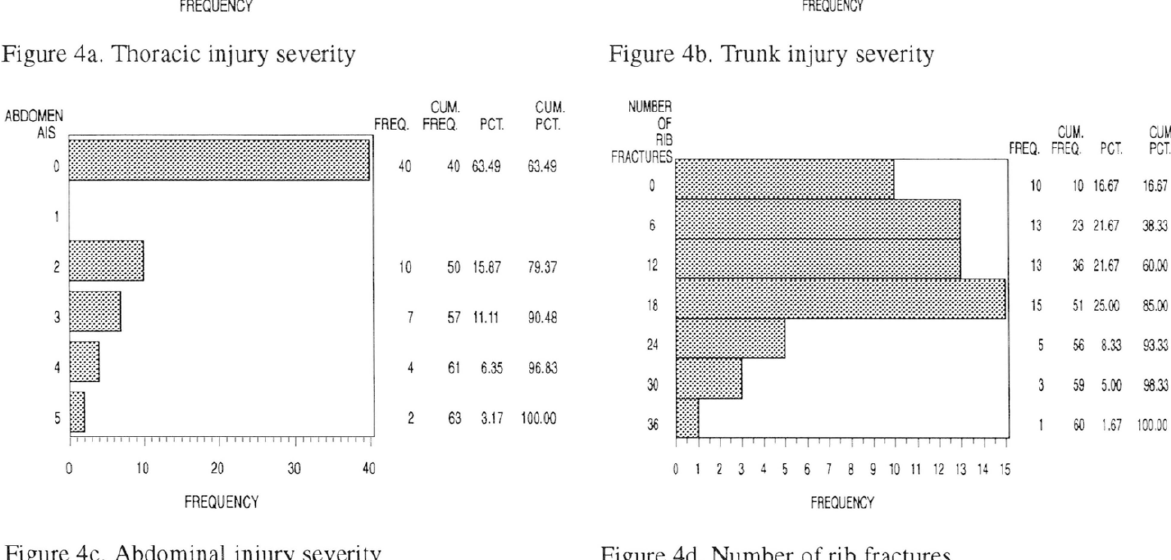
Figure 4c. Abdominal injury severity Figure 4d. Number of rib fractures FIGURE 4 Frequency of the injury severity of (a) thoracic, (c) abdominal, (b) trunk injuries, and (d) number of rib fractures.